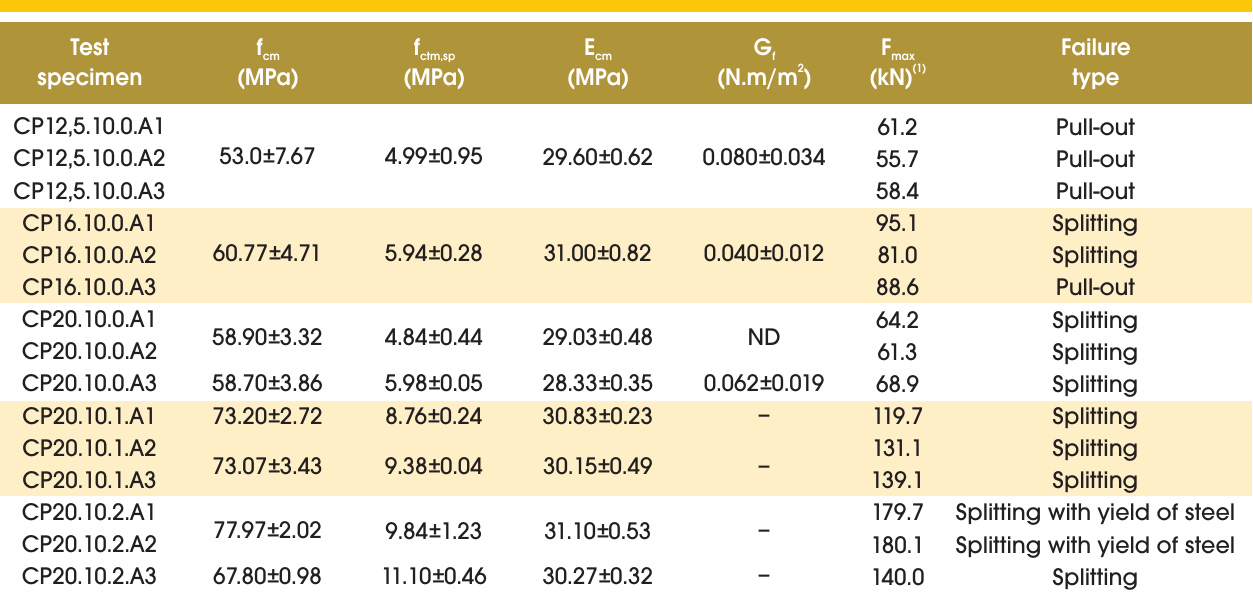
Table 5 – Results of concrete properties and splitting